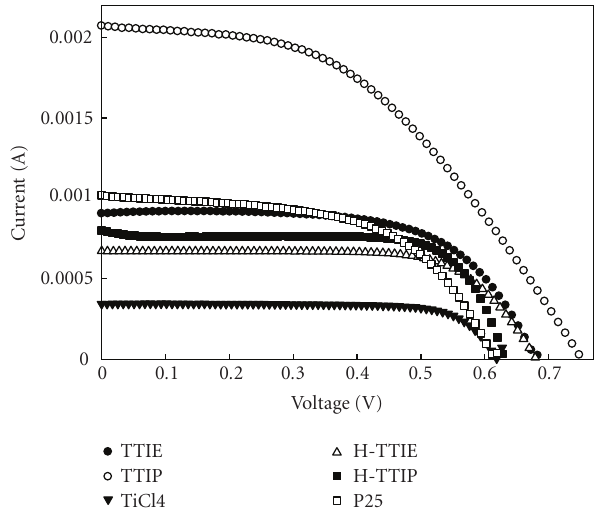
Figure 10: Photocurrent voltage characteristics of nanocrystalline TiO 2 films prepared with di ff erent